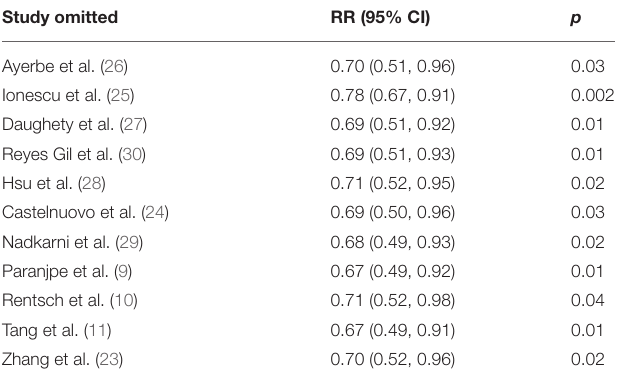
TABLE 4 | Sensitivity analysis by omitting each study in random-effects model. TABLE 5 | Sensitivity analysis by omitting studies performed outside of the USA in random-effects model.